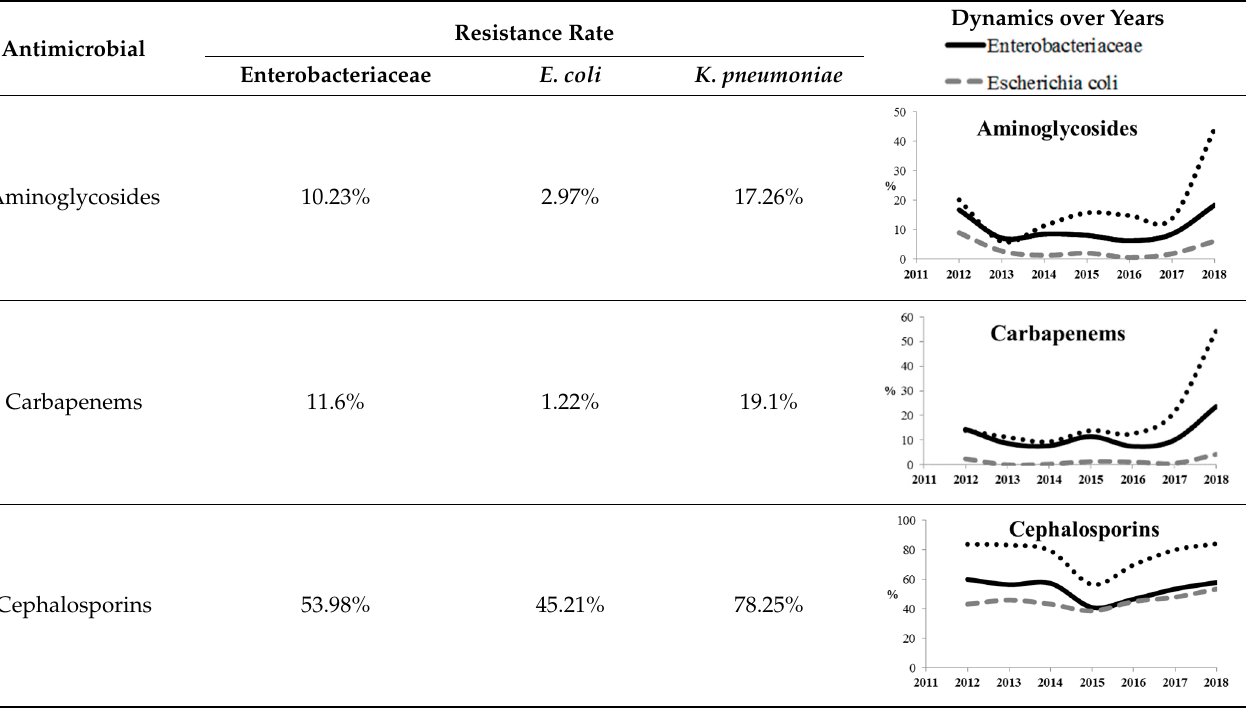
Table 5. The dynamics of the resistance rates of Enterobacterales , E. coli, and K. pneumoniae isolates to different classes of antimicrobial agents.